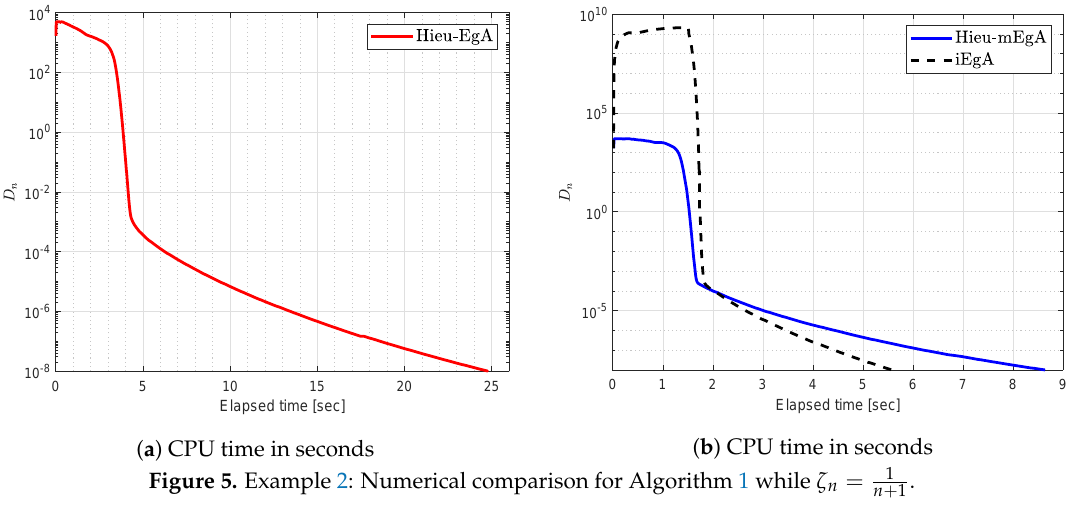
Figure 5. Example 2: Numerical comparison for Algorithm 1 while ζ n = 1